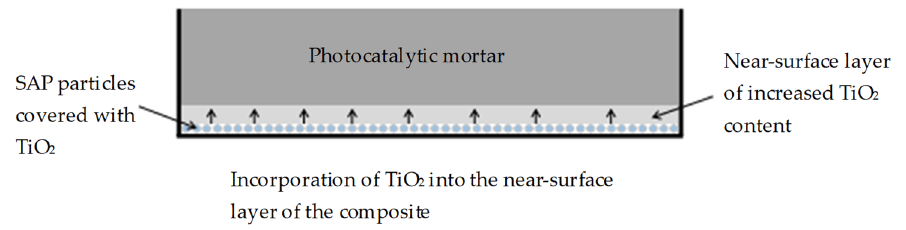
Figure 3. Method of surface modification with a reverse layer order—after demolding, the bottom surface was considered as an exposed surface and tested in air purification tests.